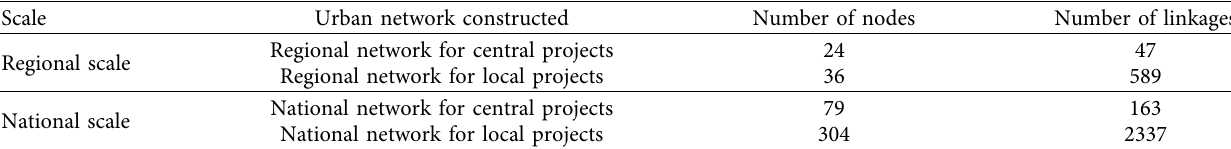
Table 2: The four GPA-based urban